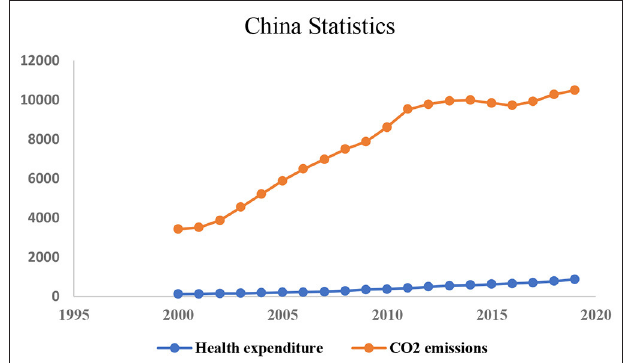
FIGURE 1 | China’s health expenditure and CO2 emissions over the period of 2000-to